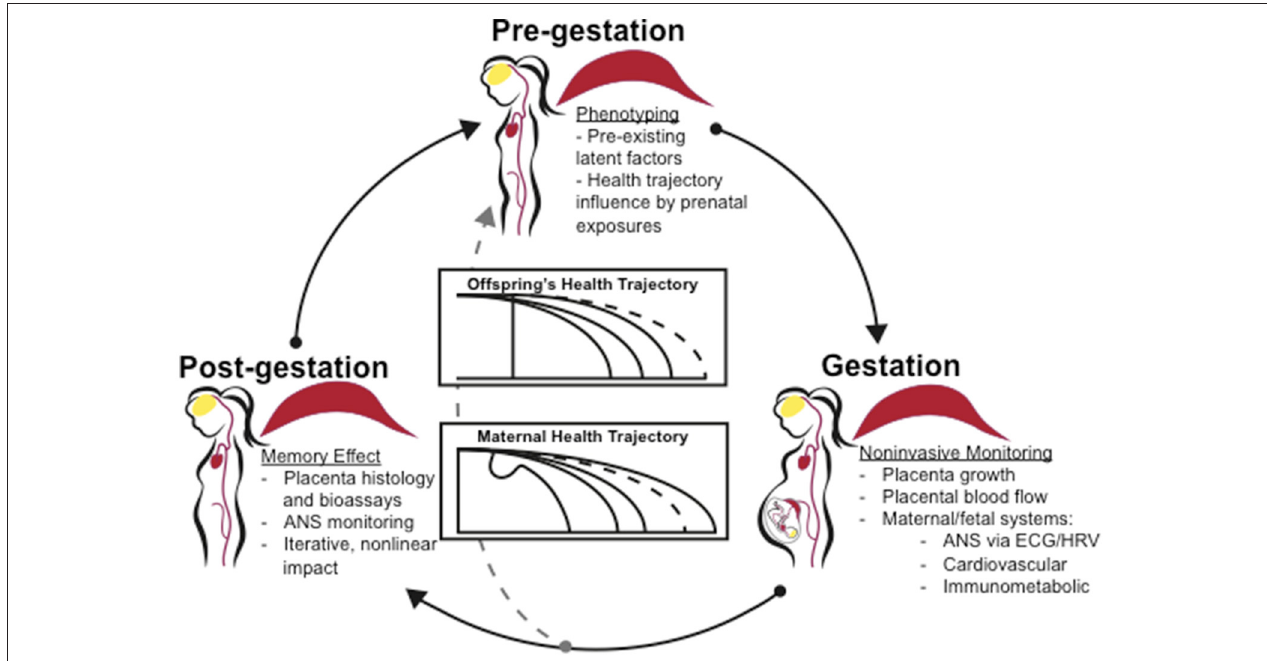
FIGURE 2 | Clinical application of the concept “placenta as a programming agent”. Individual phenotypes and health trajectories may be influenced by both an individual’s prenatal development as well as pregnancy complications. Clinical assessment of individual phenotypes by noninvasive biomarkers and with respect to developmental trends may shed light on disease prevention, improved treatment options and disease management. ANS activity, monitored noninvasively via EGG, may serve as proxy for maternal, fetal, and offspring’s memory of adaptations to the pregnancy indicating health trajectories. Combined with assessment of placenta and latent factors including cardiovascular and immunometabolic status, we may gain a more individualized prognostic and diagnostic view of pregnancy course with respect to maternal and offspring’s health outcomes. ANS, autonomic nervous system; EGG, electrocardiogram; HRV, heart rate variability.